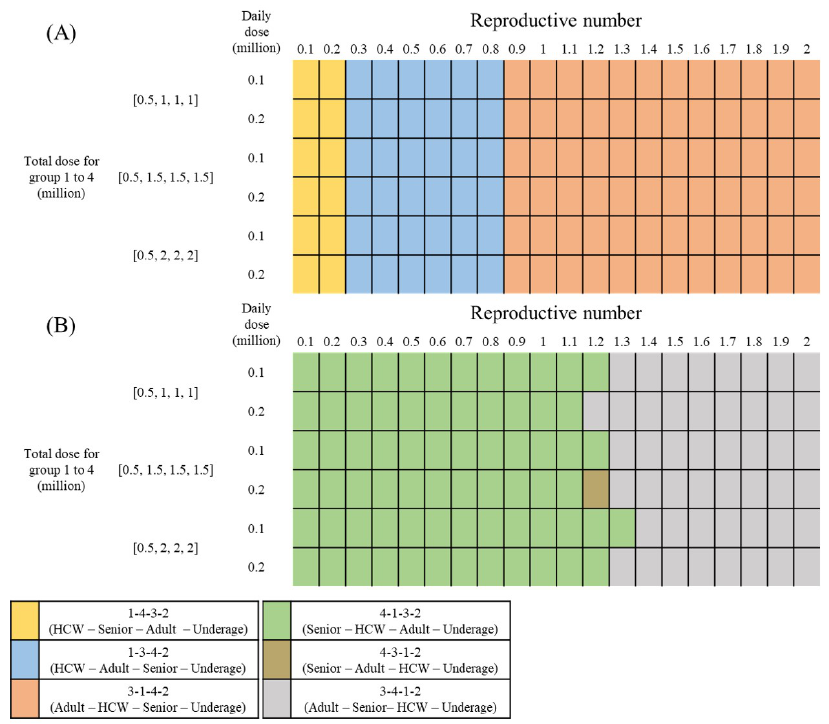
Figure 7. Best vaccination order for 120 scenarios. ( A ) minimizing incidence, and ( B ) minimizing mortality. Table 4. Simulation results depending on the different vaccination orders in the same scenario (vaccine supply for each group: (0.5, 1.5, 1.5, and 1.5) M , daily dose number: 0.1 M , and reproductive number: